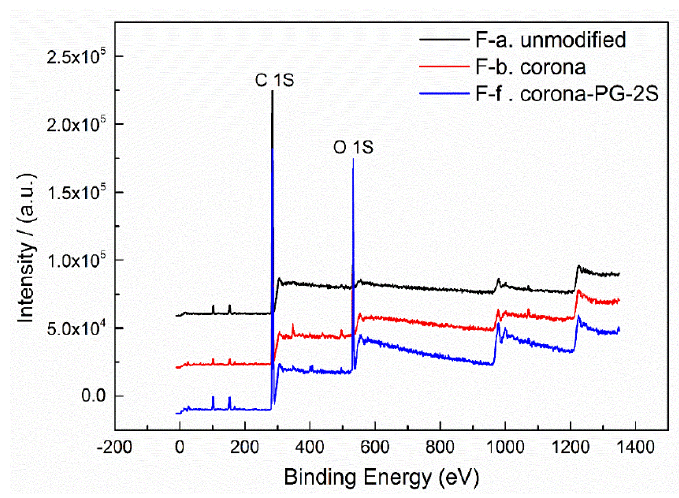
Figure 9. Fiber surface element analysis of X ‐ ray photoelectron spectroscopy (XPS) spectra of the fiber treated by method F ‐ a, F ‐ b and F ‐ f at 0.10 g/mL PVA.